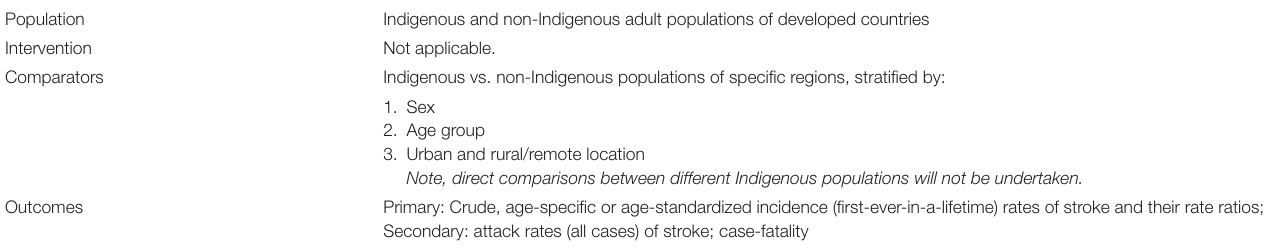
TABLE 1 | PICO framework. Population Indigenous and non-Indigenous adult populations of developed countries Intervention Not